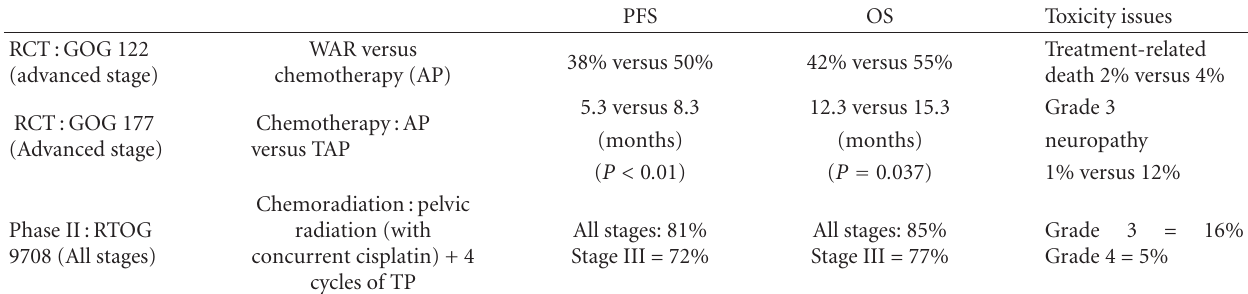
Table 4: Some important studies of chemotherapy in endometrial